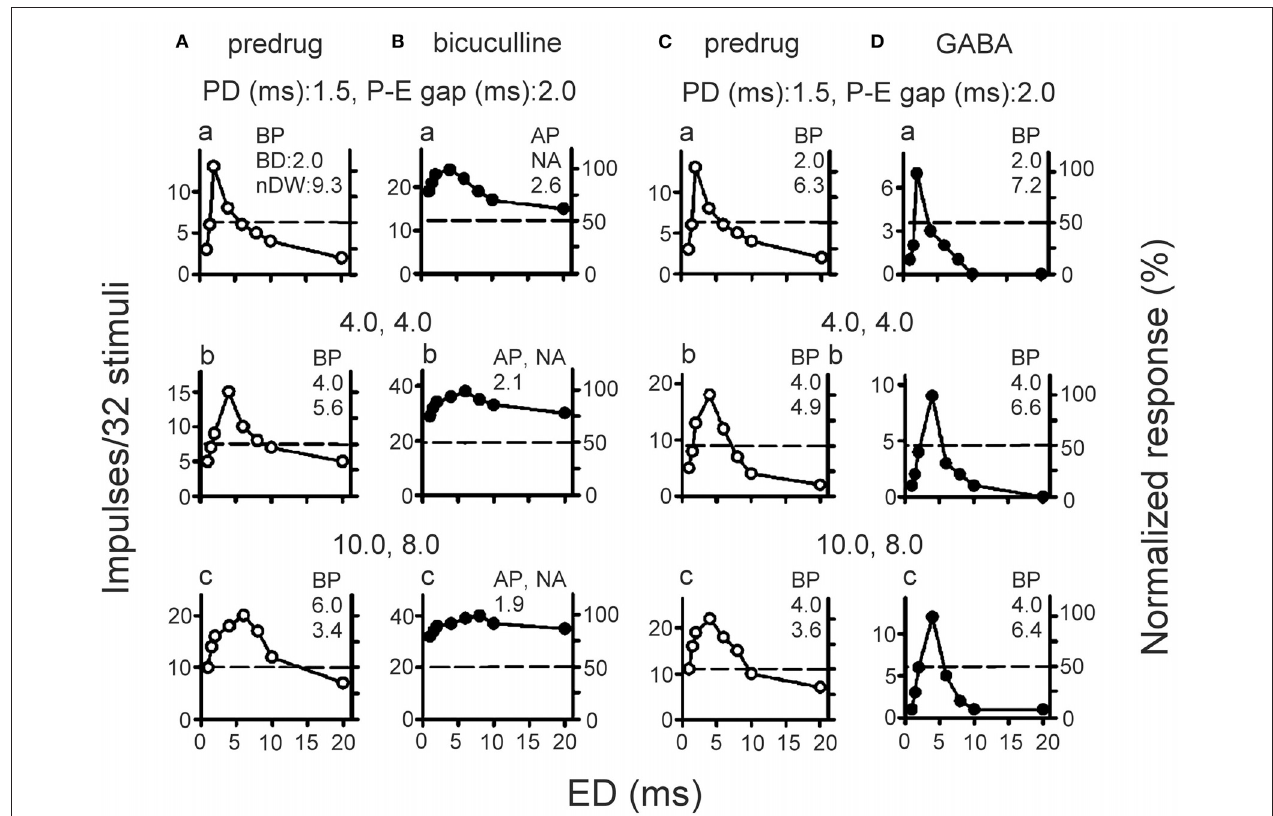
FIGURE 4 | (A,B) Echo duration tuning curves of two collicular neurons determined with three P-E pairs of varied pulse duration and P-E gap before (predrug, A,C ) and during bicuculline (B) or GABA (D) application [Adapted from Wu and Jen